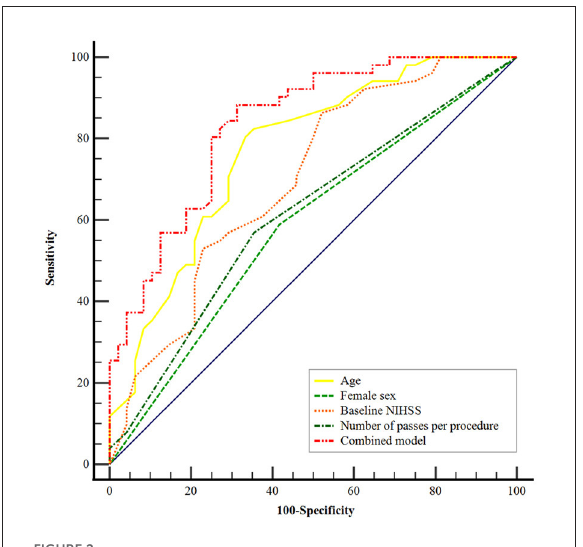
FIGURE2 Receiver operating characteristic curves were generated to evaluate the efficacy of age, female sex, baseline NIHSS score, and number of passes per procedure independently and combined for the prediction of futile recanalization after mechanical thrombectomy. The area under the curve of the combined model was 0.84 (95% CI, 0.75–0.90; P < 0.001). NIHSS, National Institute of Health Stroke